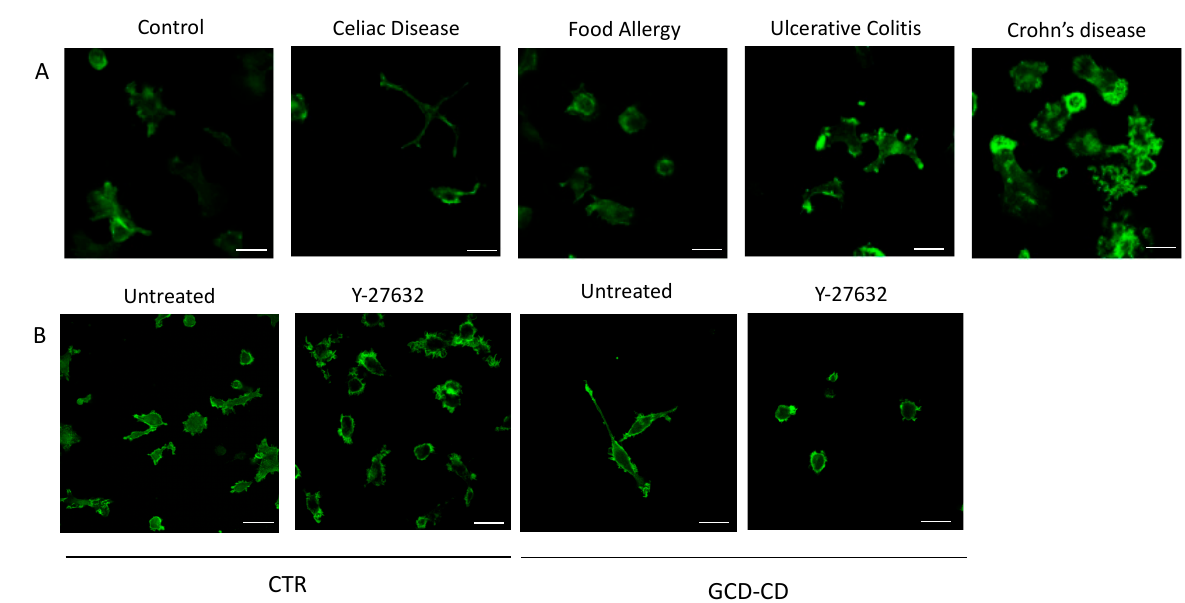
Figure 3. DC shape and cytoskeleton evaluated by immunofluorescence staining. ( A ) Representative immunofluorescence images of FITC-conjugated phalloidin staining, highlighting the actin cytoskeleton of fibronectin-adhering DCs from one control and patients with GCD-CD, food allergy or inflammatory bowel disease (ulcerative colitis and Crohn’s disease), showing that the elongated morphology of DCs was specific to CD. FITC-conjugated phalloidin staining was performed on DCs plated on coverslips pre-coated with fibronectin at a concentration of 2.5 × 10 5 cells/mL. One representative image out of at least three subjects per group is shown. Each experiment was done in duplicate; six pictures were taken for each duplicate. Scale bar = 7 µm. ( B ) Representative immunofluorescence images of phalloidin staining of DCs from four GCD-CD patients and controls plated on coverslips pre-coated with fibronectin at a concentration of 2.5 × 10 5 cells/mL and incubated at 37 °C for 3 h before (Untreated) and after treatment with the Y-27632 Rho-associated protein kinase (ROCK) inhibitor. Treatment with Y-27632 prevented protrusion formation and cell shape alterations observed in GCD-CD DCs (right panels), confirming that the DC shape of CD patients depended on RhoA activation.